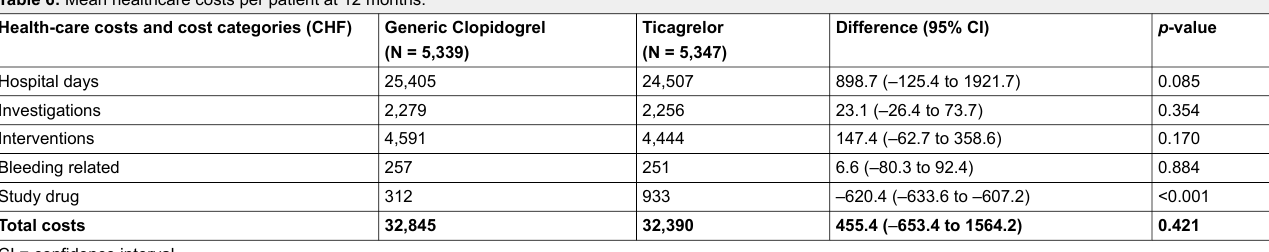
Table 6: Mean healthcare costs per patient at 12 months. Health-care costs and cost categories